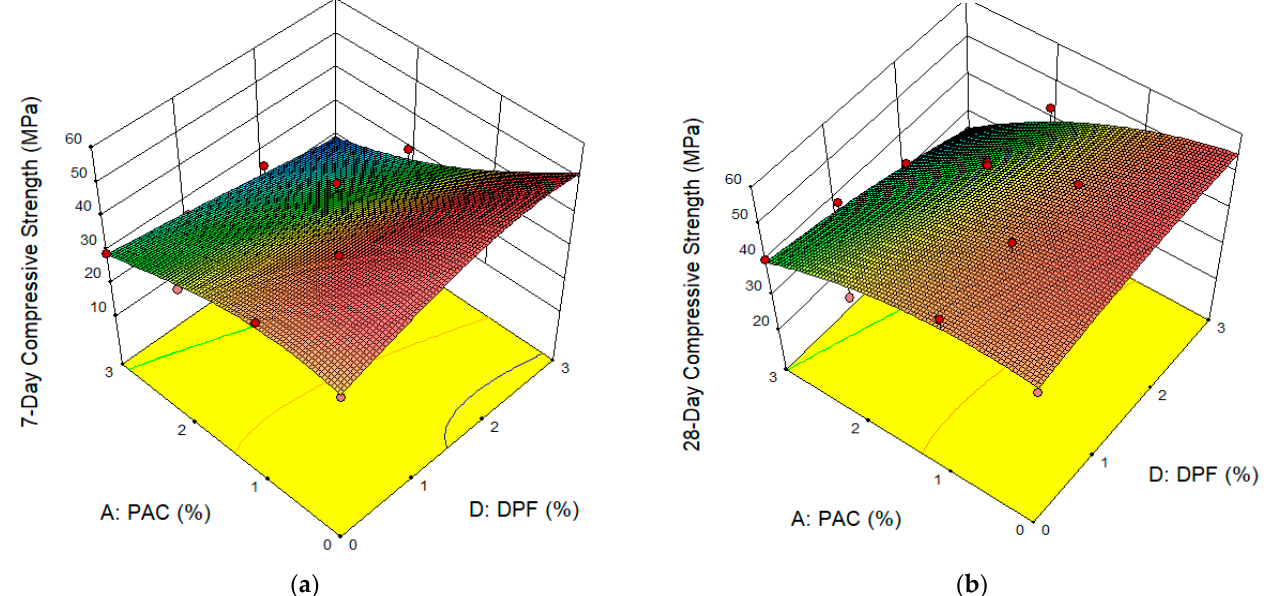
Figure 7. Surface Plots for Compressive Strengths. ( a ) 7-day Compressive Strength, ( b ) 28-day Compressive